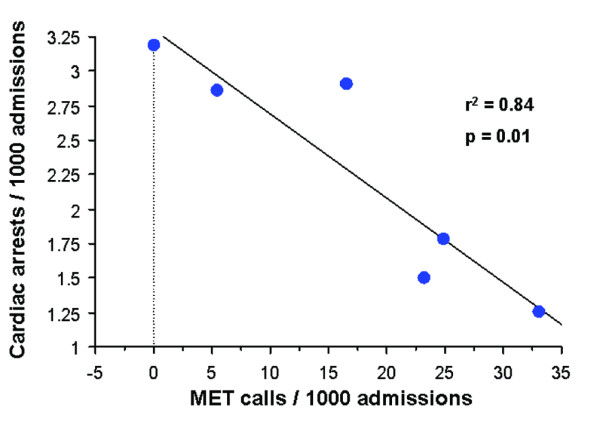
Correlation between the number of medical emergency team (MET) calls and the rate of cardiac arrests between 1999 and 2004.